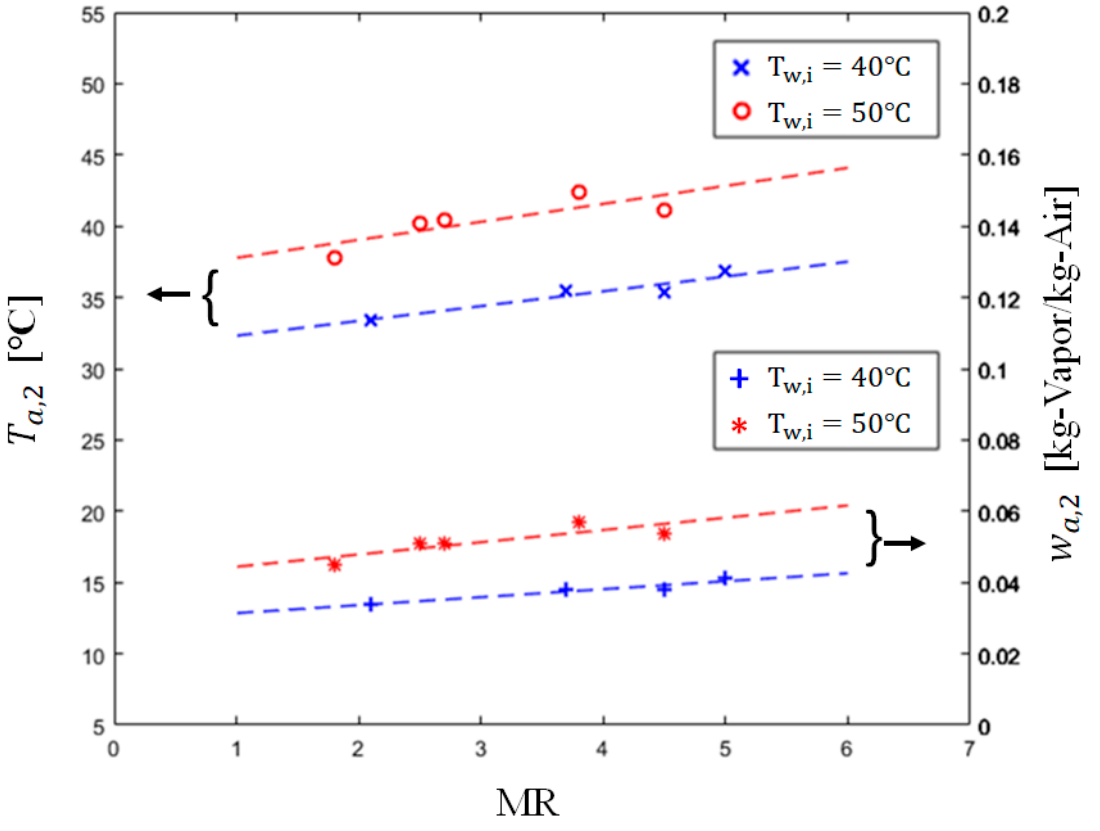
Figure 6. Left y -axis shows the average air temperature in the air duct T a ,2 as a function of MR ; Right y -axis shows the absolute humidity in the air duct ( w a ,2 ) as a function of MR . The data were calculated based on the measured temperature and relative humidity in the air duct and averaged across the section.